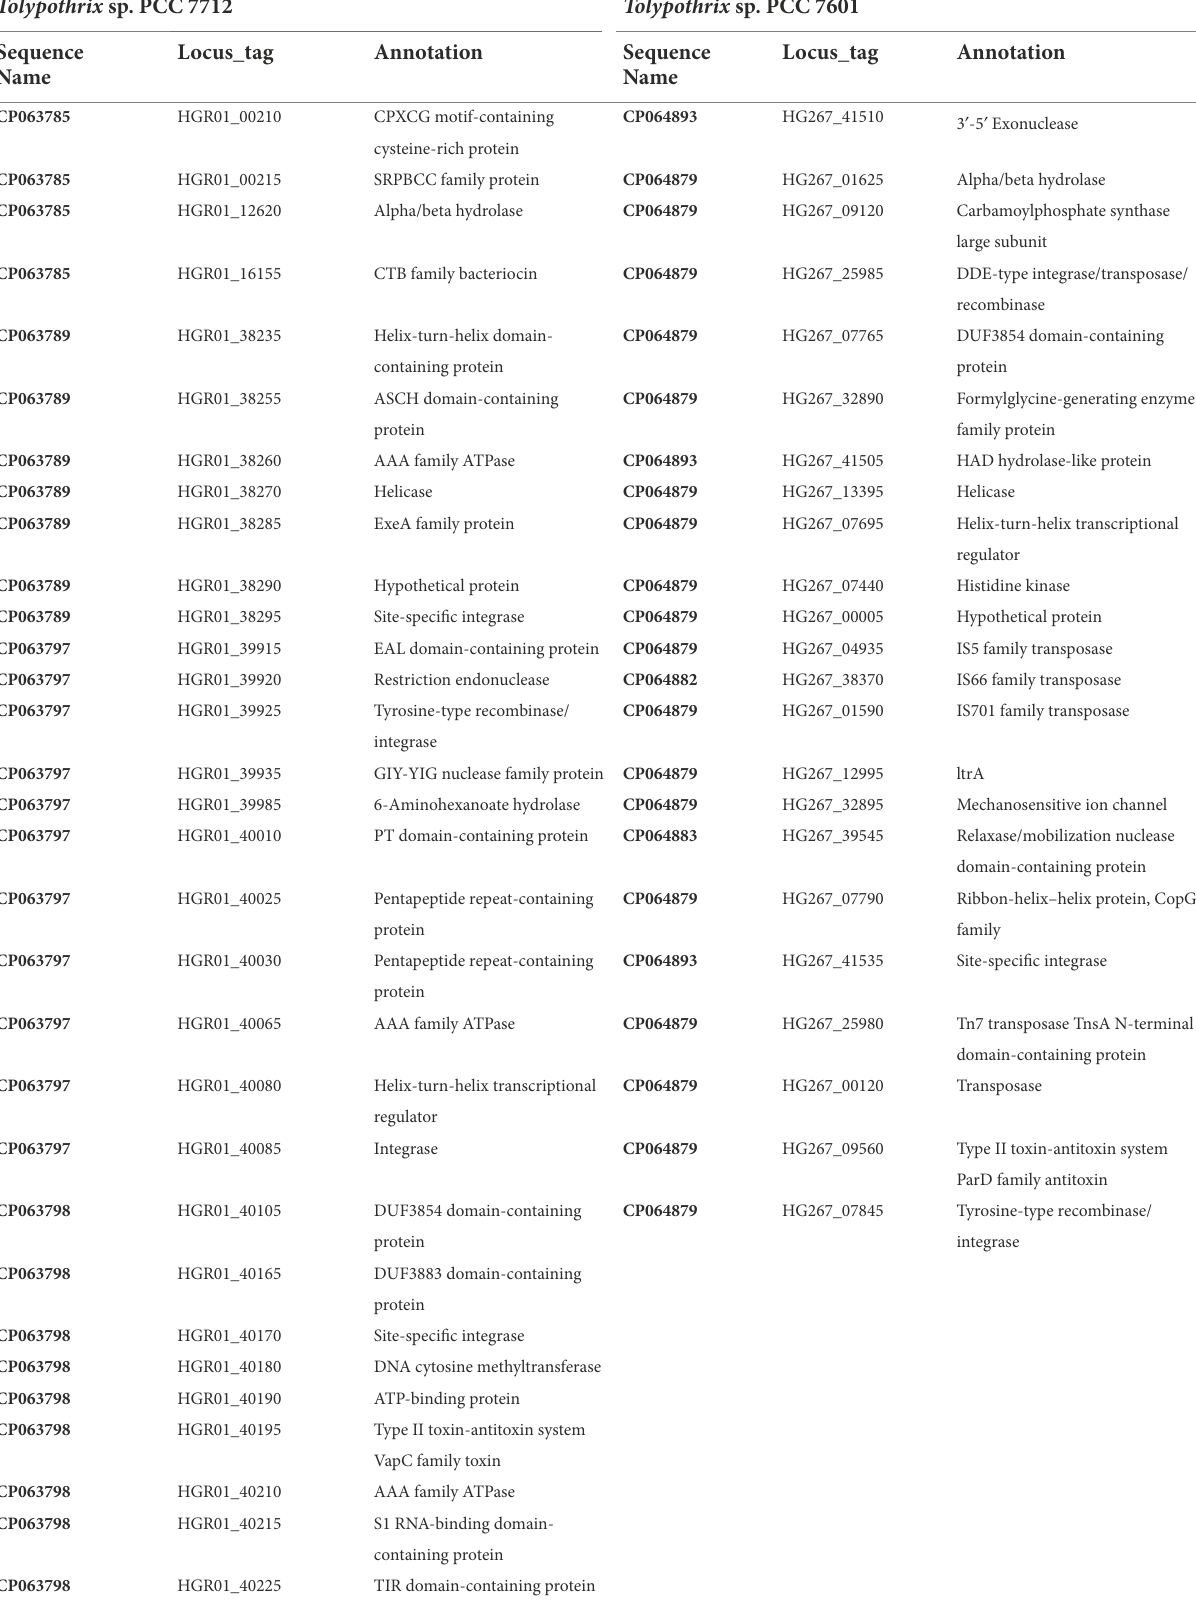
TABLE 2 Examples of unique protein-coding regions found in the genome of PCC 7601 and PCC 7712. Tolypothrix sp. PCC